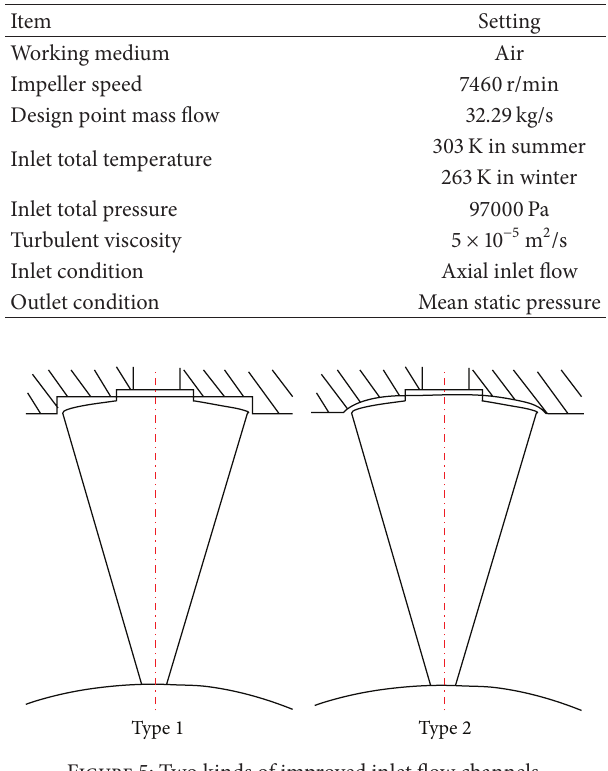
Figure 5: Two kinds of improved inlet flow channels.